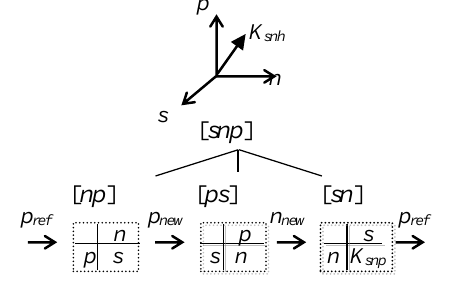
Fig. 2. Vector-matrix model of a pumping application with control